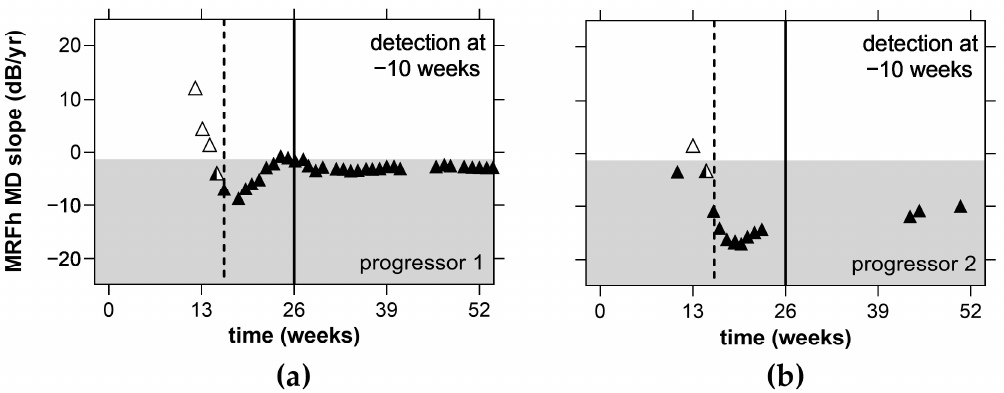
Figure 9. Detecting change in two cases with progression identified by the reviewing clinician. The MRFh MD slope was calculated over a minimum of ≥ 5 reliable tests. Unfilled triangles represent non-progressing slopes (> − 1.25 dB/yr) and semi-filled triangles represent unconfirmed change (single point ≤− 1.25 dB/yr). Filled triangles are slopes that indicate confirmed change (second consecutive result ≤− 1.25 dB/yr, grey shaded area). Dashed lines indicate confirmed progression at retest. Solid lines indicate next clinical review. Average MD trends for ( a ) progressor 1: MRFh = − 2.4 dB/yr, HFA GPA = − 2.2 dB/yr; ( b ) progressor 2: MRFh = − 10.2 dB/yr, HFA GPA = − 1.3 dB/yr).